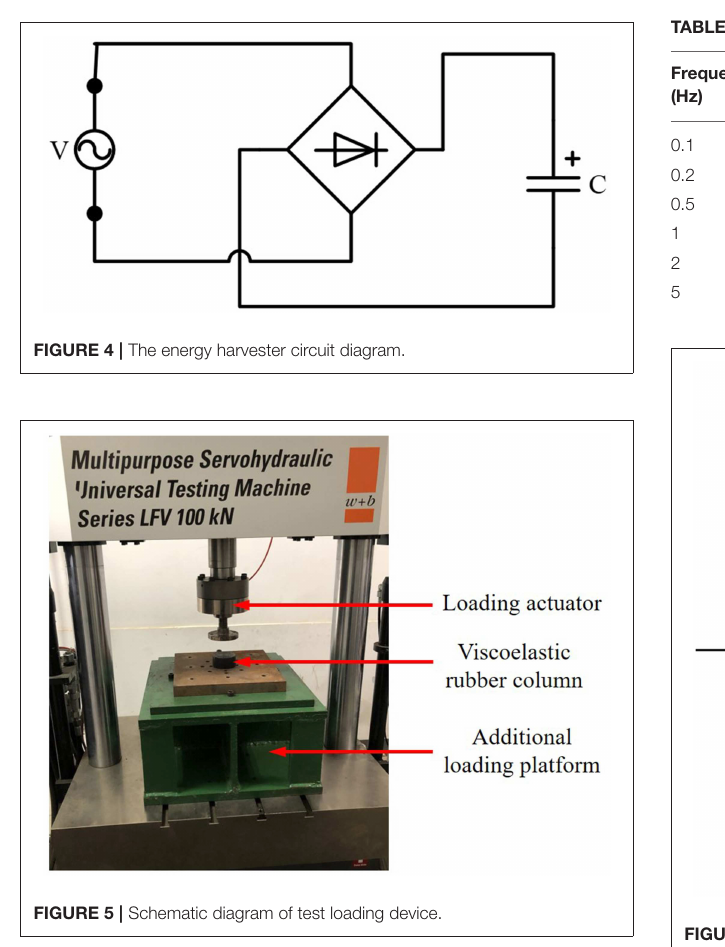
and the moveable part of the linear generator, as shown in Figure 2 . When the heel moves down, the solid insole is pushed down. With the solid insole moving down, the rubber column is gradually compressed and the linear generator moves vertically downward. When the heel lifts up, the elasticity of the rubber column will restore it to the initial state, while the